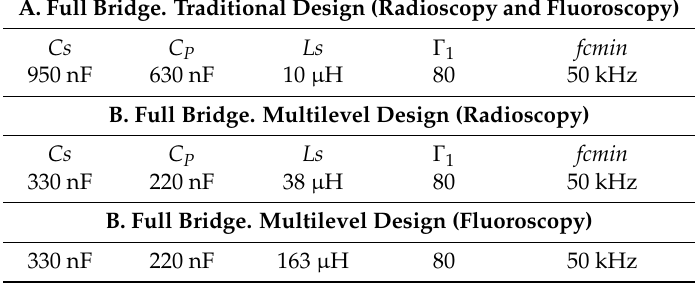
Table 2. Design parameters for traditional and multilevel LCC